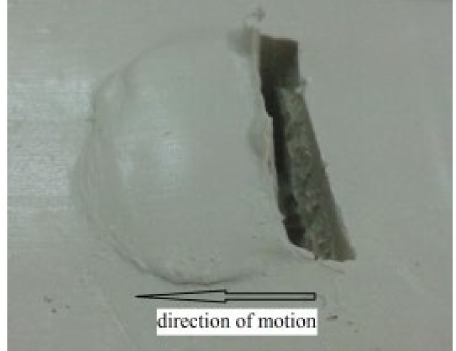
Figure 11. A rut shaped by the grouser (the grouser is